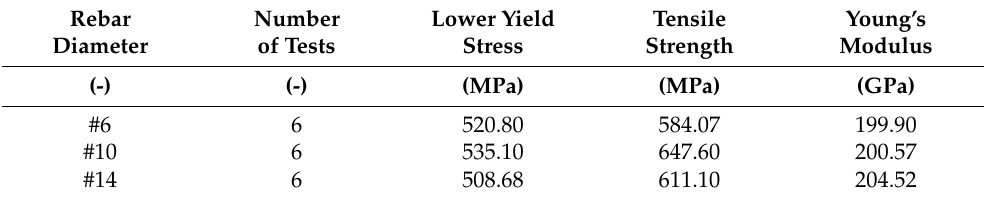
Table 4. Basic strength properties of reinforcing steel.